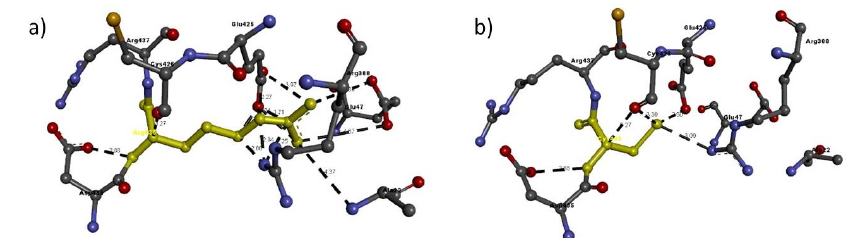
Figure 3. Molecular interactions of ( a ) Arg436 and ( b ) Cys436 (in yellow) of the modeled TIE1 protein with adjacent residues. Table 6. Details of molecular interactions of Arg436 and Cys436 of the modeled TIE1 protein with adjacent residues.